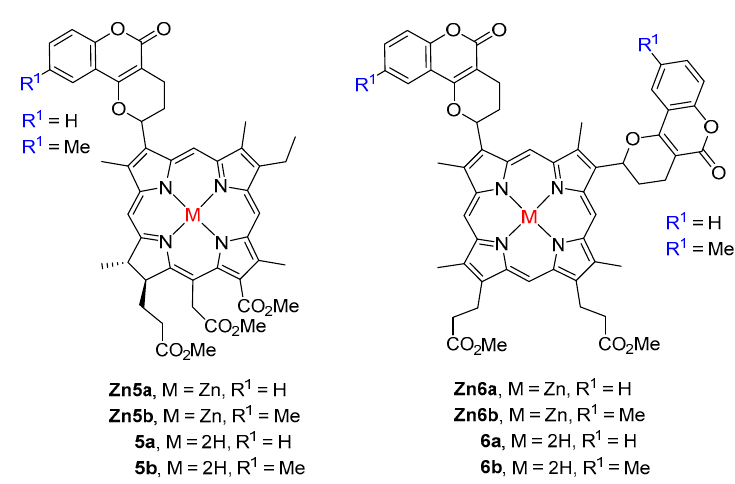
Figure 1. Structures of coumarin conjugates obtained from natural porphyrins [43].